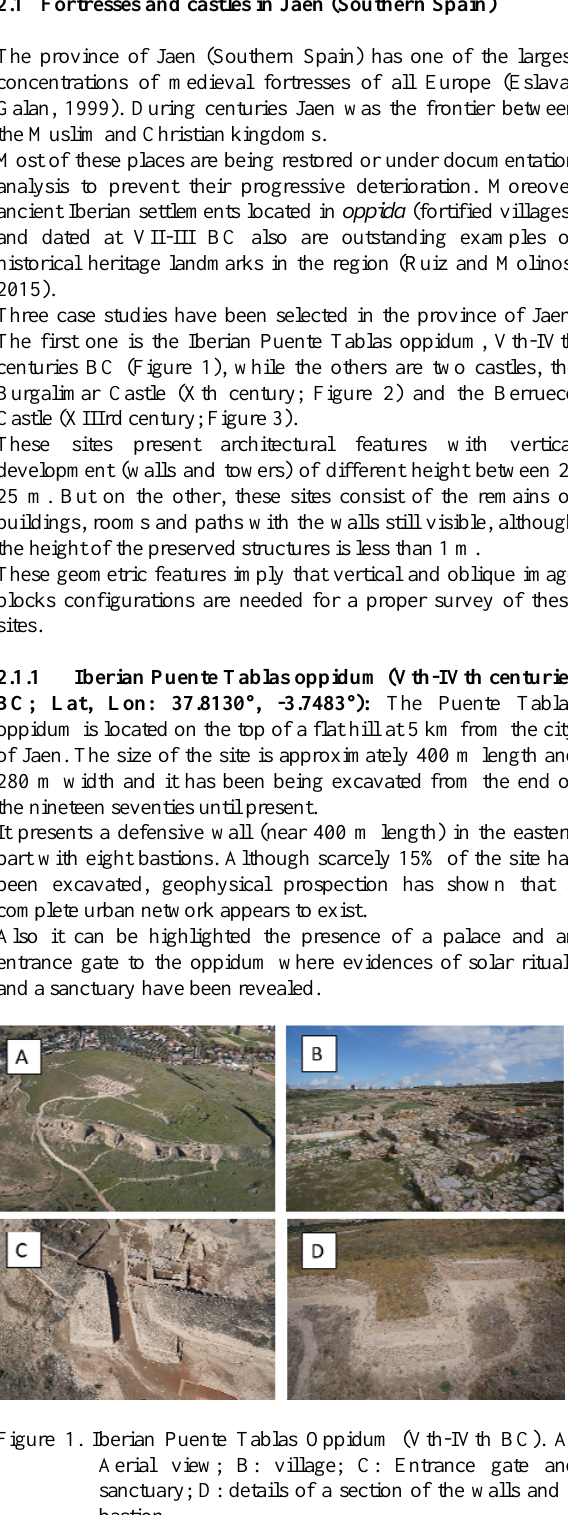
Figure 3. Berrueco Castle (XIIIrd century). Left: aerial view; Right: original battlements and